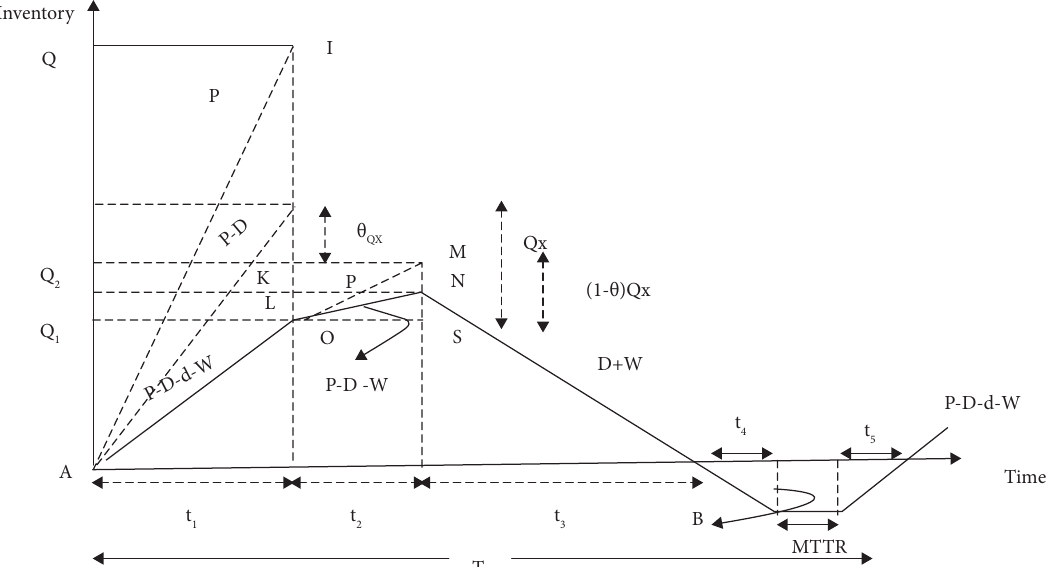
Figure 1: Te inventory position of the EPQ model with rework, lack of backlog and the state of PM